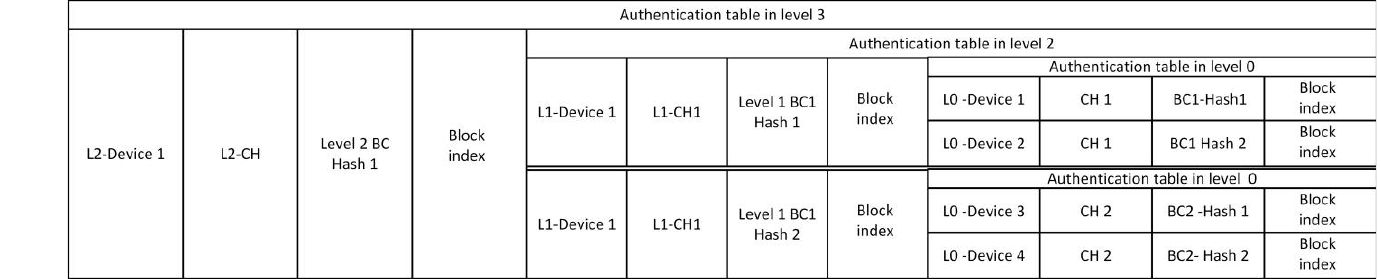
Figure 5. Authentication table